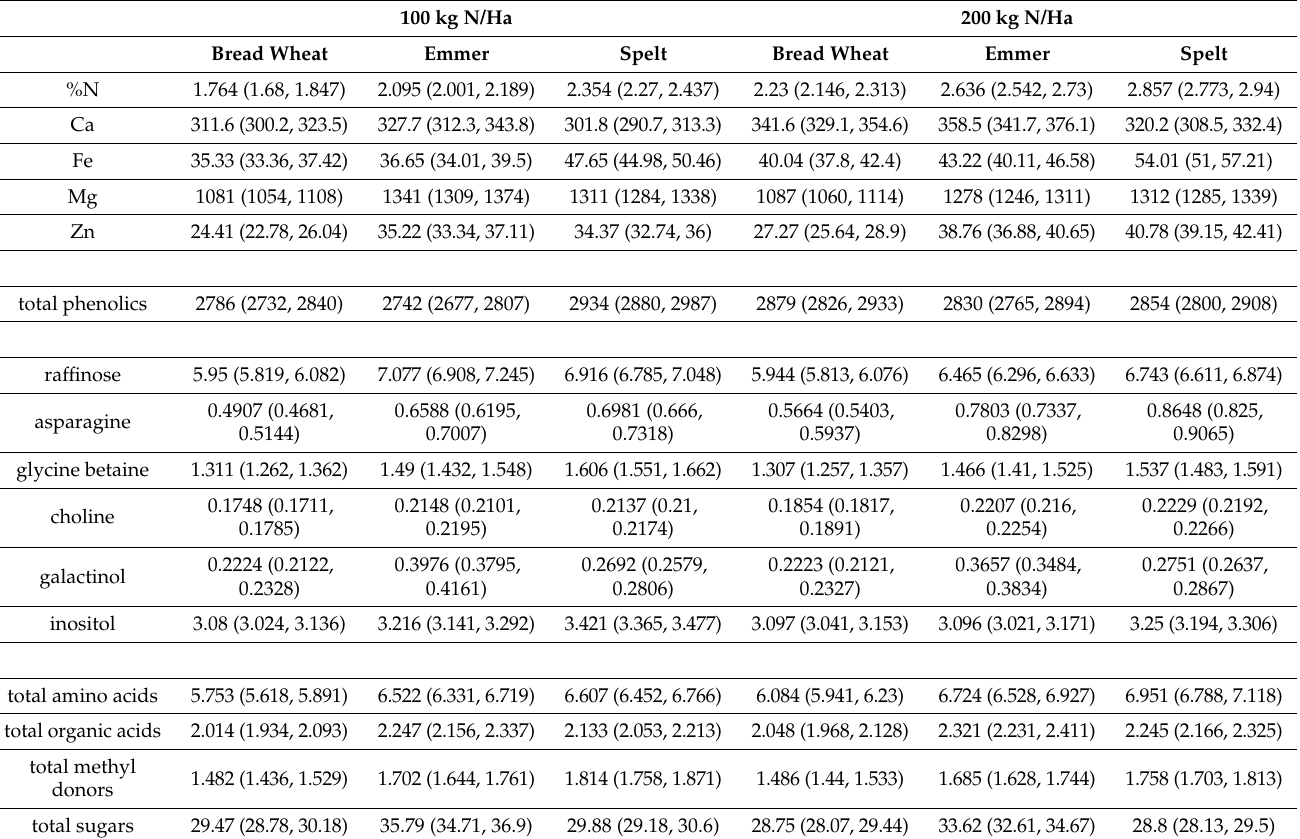
Table 1. Means and 95% confidence intervals (in parentheses) of contents of selected minerals, metabo- lites and groups of metabolites in grain of the three types of wheat grown with 100 and 200 kg N/Ha. 100 kg N/Ha 200 kg N/Ha Bread Wheat Emmer Spelt Bread Wheat Emmer